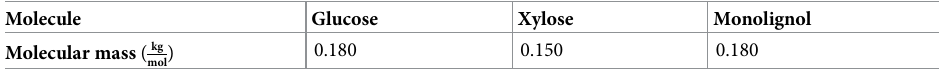
Table 2. Molecular masses of the constituents of the lignocellulose sub-units, obtained from literature and rounded to three digits. The value for the representative monolignol was taken as the mean value of the molecular masses of the three main monolignols (coumaryl alcohol, coniferyl alcohol and sinapyl alcohol). Molecule Glucose Xylose Monolignol Molecular mass ( kg ) 0.180 0.150 0.180 mol